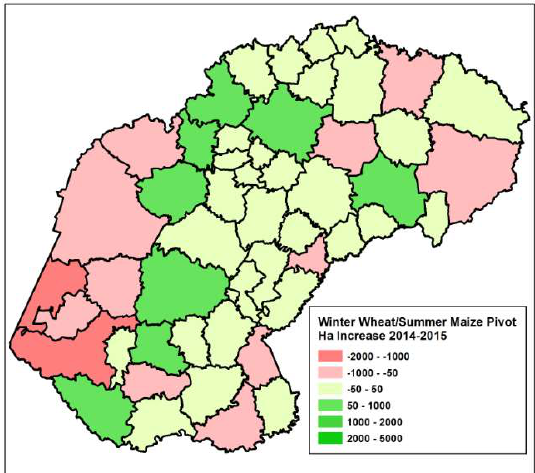
Figure 33. Double crop of wheat in winter and maize in summer area increase or decrease under pivot irrigation per district between 2014 and